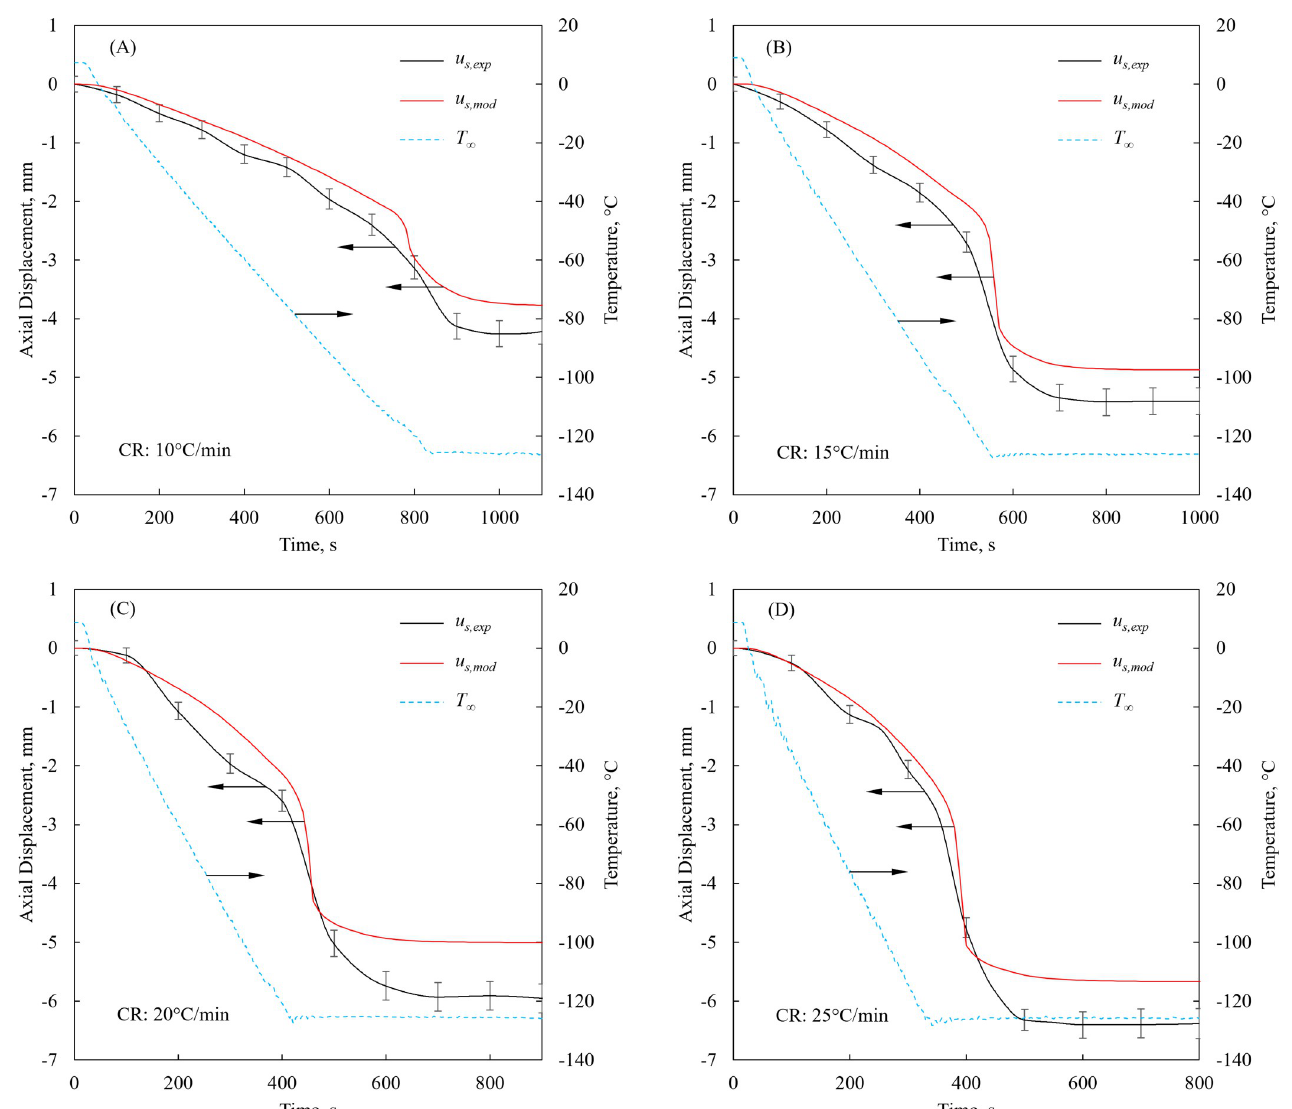
Fig 5. Displacement history along the centerline of the cuvette subject to a constant cooling rate (CR). The CR ranges from 10˚C/min to 25˚C/min from an initial temperature of 10˚C, where computer modeling results are obtained for a 2D TF problem, and the subscripts exp and mod refer to experimental data and modeling results,